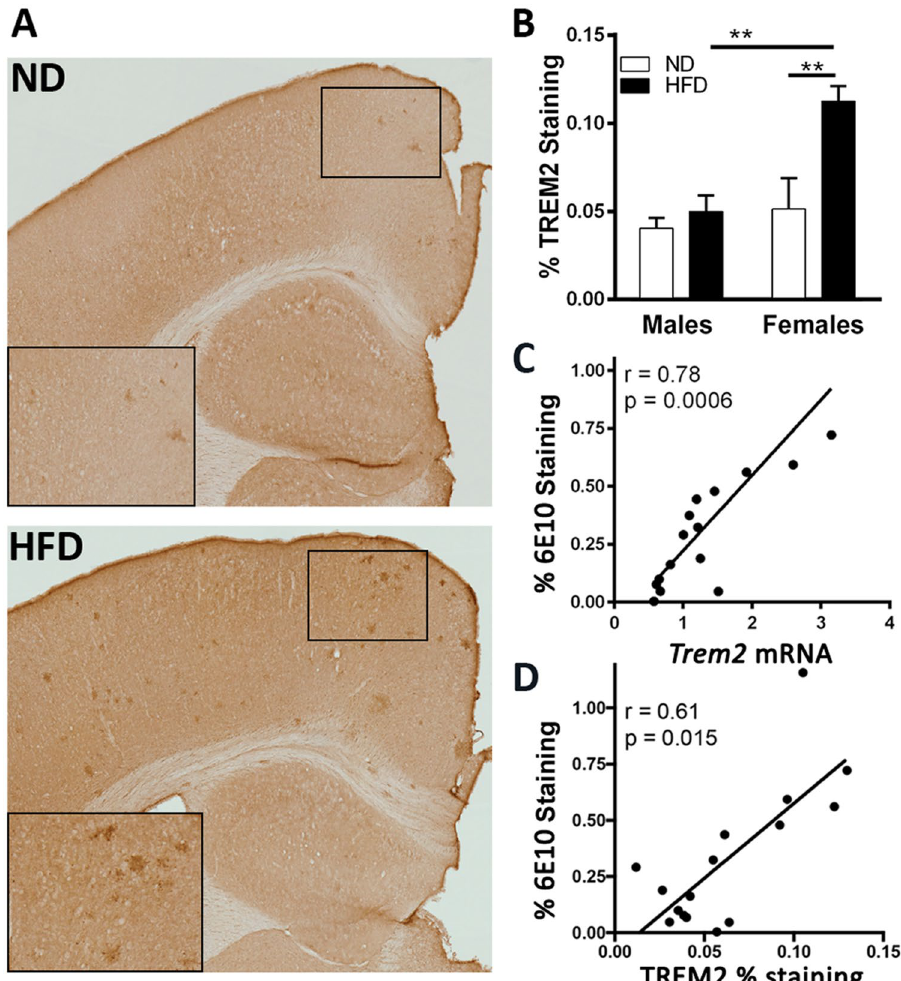
Figure 3. HFD increases TREM2 immunostaining in the brain. ( A ) Representative images of TREM2 staining in brains of mice fed ND or HFD. ( B ) Percentage of TREM2 stained area (N = 4 mice/gender/group). Analysis by two-way ANOVA; a significant interaction between diet and gender (F (1,12) = 5.82, p = 0.0328), and a significant main effects of diet (F (1,12) = 9.567, p = 0.0093) and gender (F (1,12) = 11.55, p = 0.0053). ** p < 0.01 by Sidak’s multiple comparison test. ( C ) Significant positive correlation between Trem2 RNA expression and 6E10 staining (r = 0.78, p = 0.0006). ( D ) Significant positive correlation between TREM2 staining and 6E10 staining (r = 0.61, p = 0.015). Spearman’s correlation test. (N =